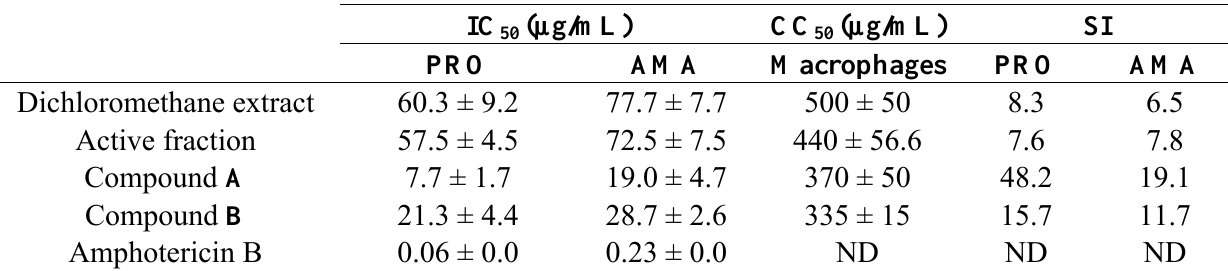
Table 1. Effects of the dichloromethane extract, active fraction and thiophene derivatives on the growth of promastigote (PRO) and axenic amastigote forms (AMA) of L. amazonensis and cytotoxicity to J774G Macrophage 8